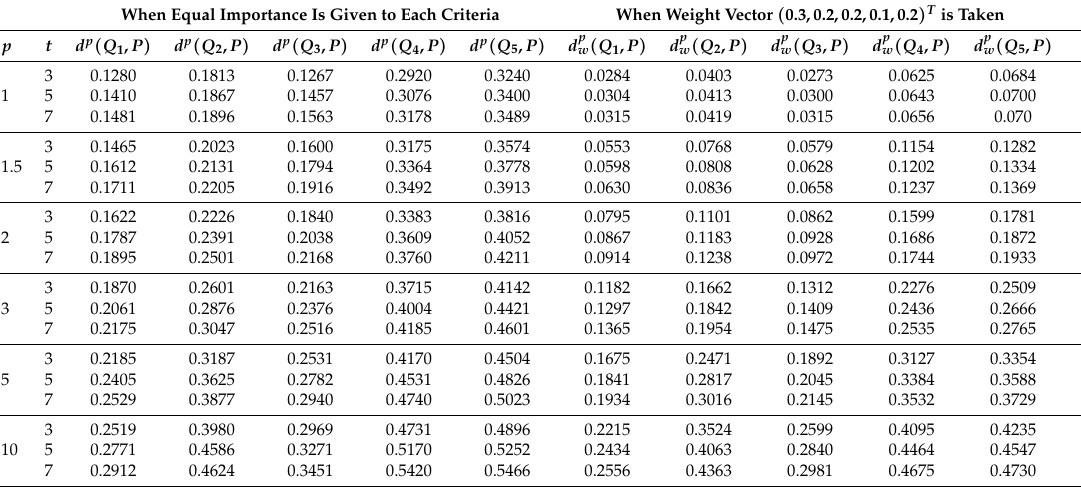
Table 4. Diagnosis result on basis of proposed distance